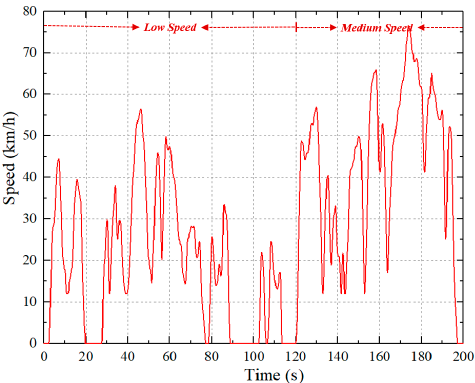
Appl. Sci. 2019 , 9 , x FOR PEER REVIEW Figure 18. The low speed and medium speed driving cycles used in the experiment.